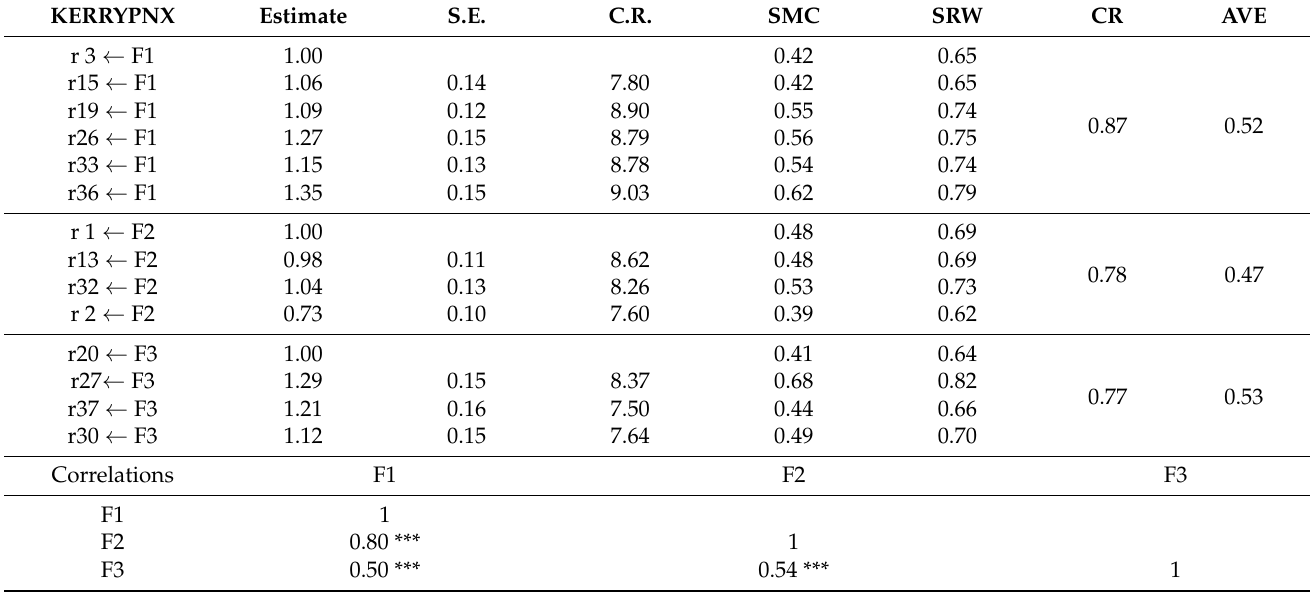
Table 4. Confirmatory analysis of